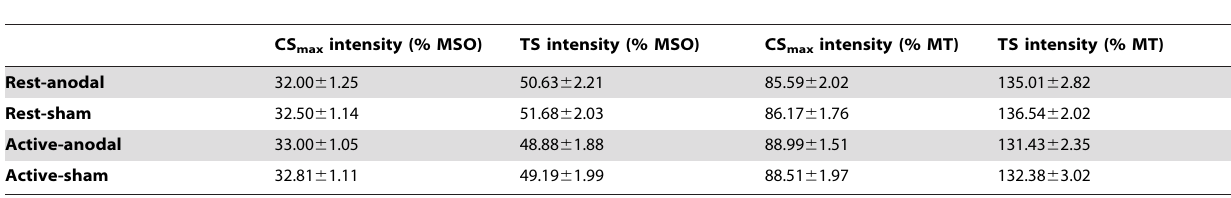
Table 1. Stimulation intensities relative to the maximum stimulator output (MSO) and motor threshold (MT).